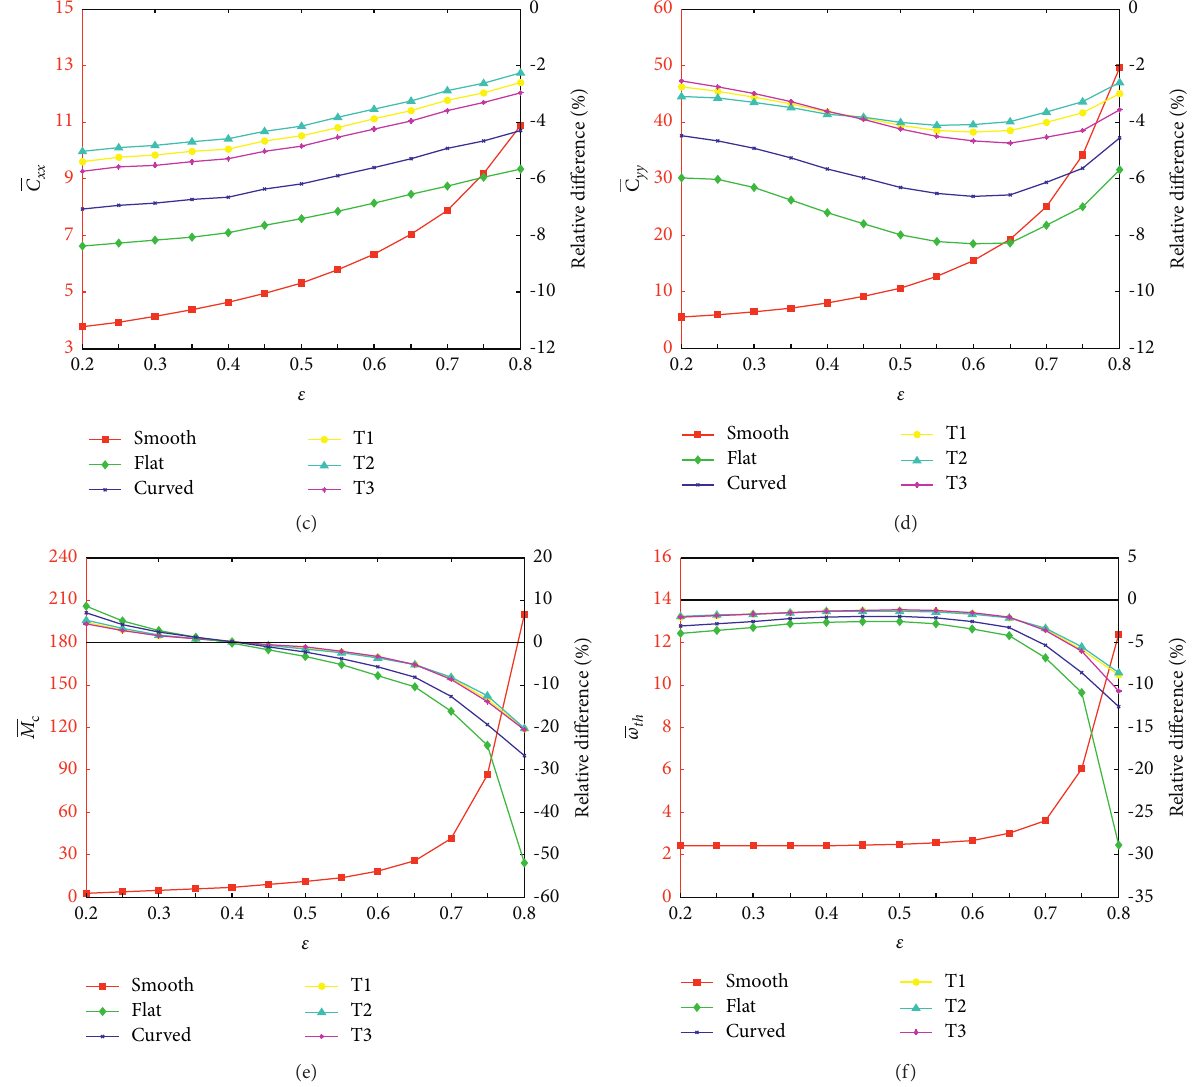
Figure 10: Effect of the eccentricity ratio on dynamic and stability performance characteristics for smooth/textured journal bearings: (a) the ); (b) the direct stiffness coefficient ( K direct stiffness coefficient ( K xx coefficient ( C ); (e) the critical mass ( M c ); (f) the threshold speed of stability ( ϖ yy